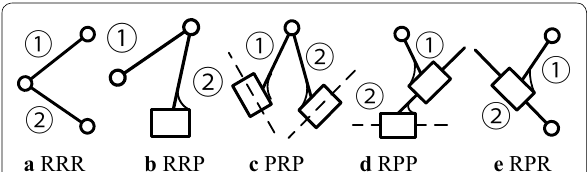
Figure 5 The whole family of 0-DOF groups consisting of n p